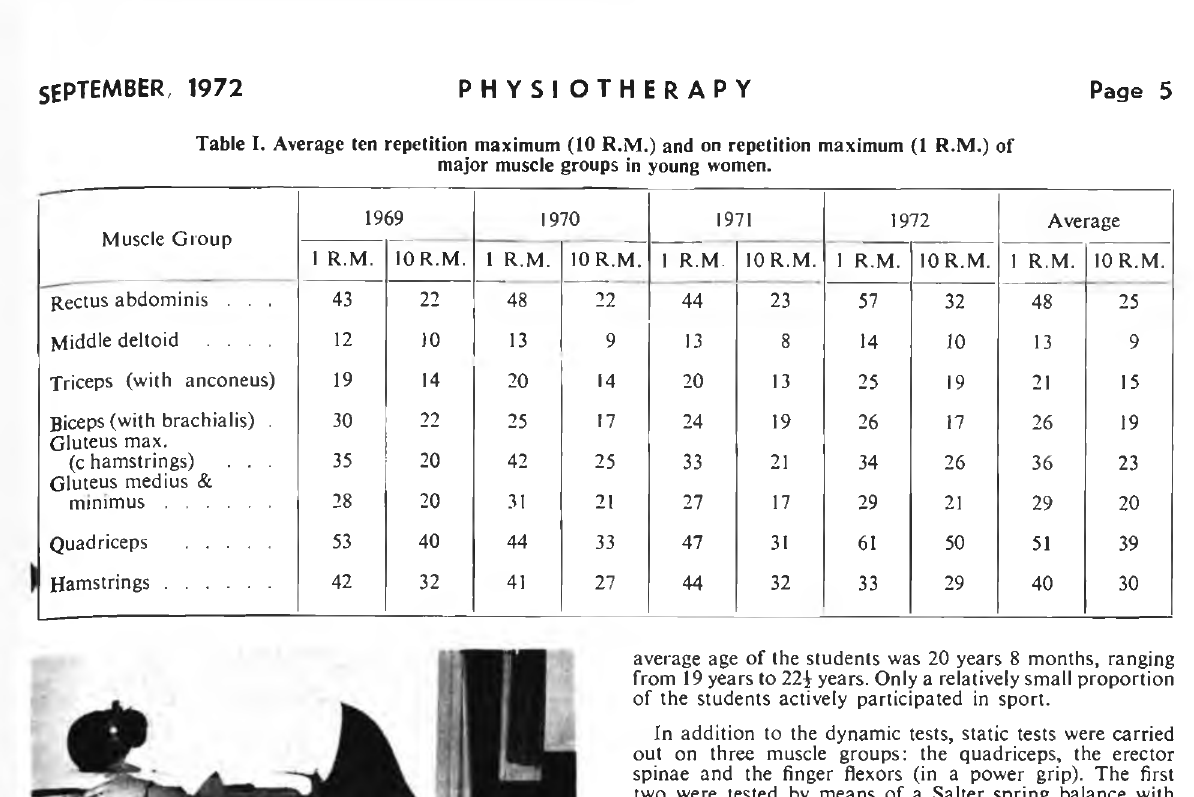
Table II. Average values for static muscle